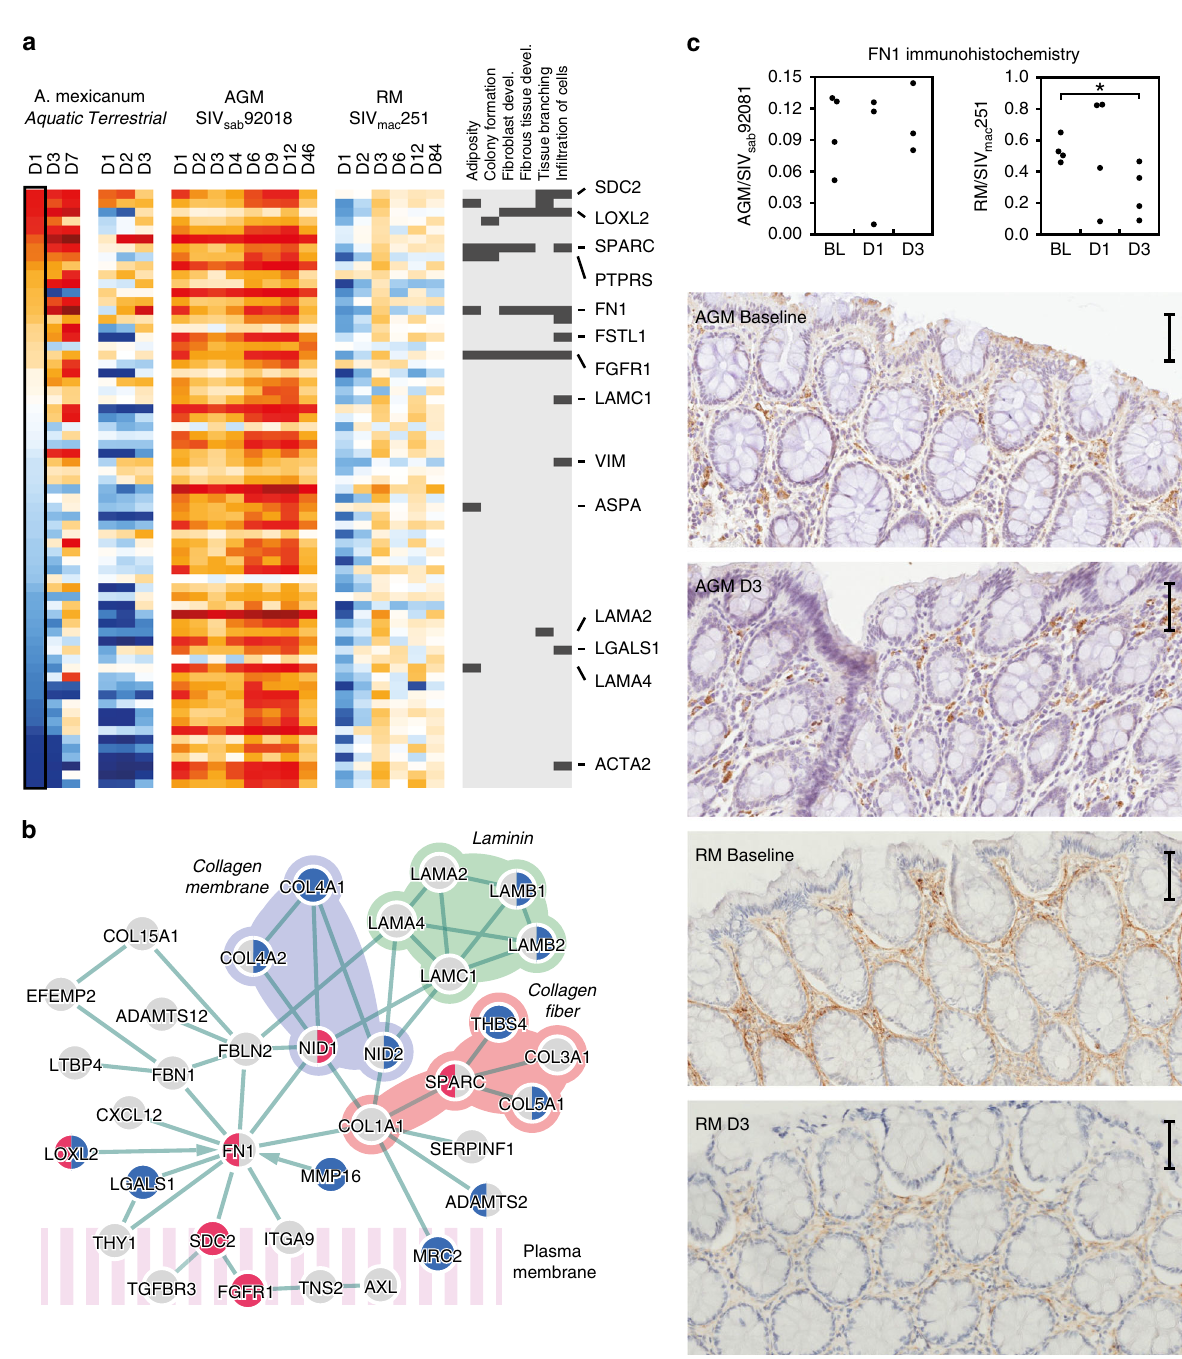
Fig. 5 CGSA showing axolotl wound healing signatures in AGMs. a Heatmap of Wound Healing Network genes in axolotl wound repair and acute SIV infection, ordered by day 1 of aquatic axolotl wound repair. The biological functions that correlate with D1 axolotl wound repair, and their associated genes are shown on the right. b A protein interaction network between proteins encoded by genes in the Wound Healing Network. Red and blue nodes indicate up and downregulation in aquatic (left) and terrestrial (right) axolotl at day 1. c Immunohistochemistry staining of fi bronectin (FN) in rectal mucosa at baseline, D1 and D3 post SIV inoculation. Right panels show quanti fi cation by pixel density, middle and left panels show fi bronectin protein expression in lamina propria. Representative images are shown below. The scale bar included in each image represents a length of 50 μ